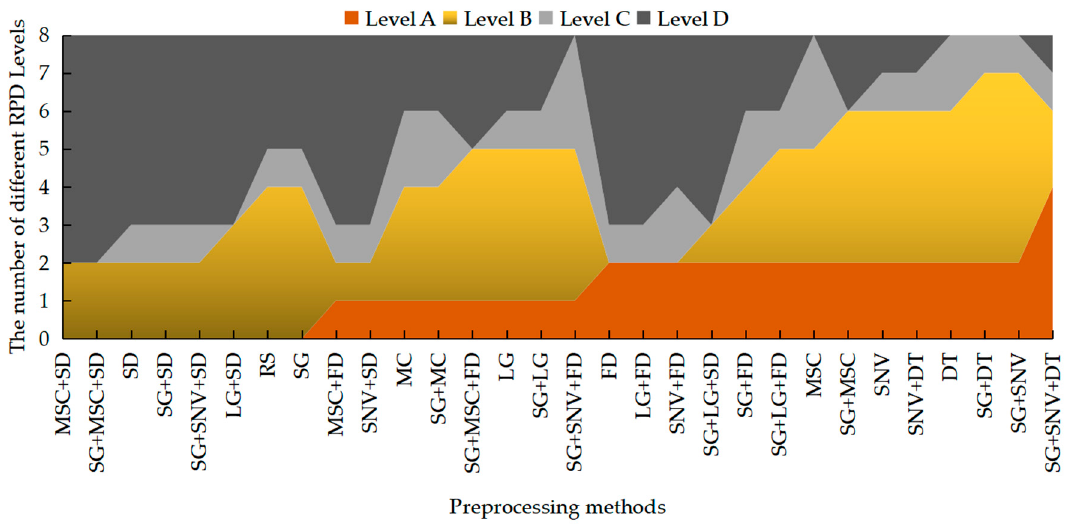
Figure 5. The RPD level of regression models with different pretreatment methods.